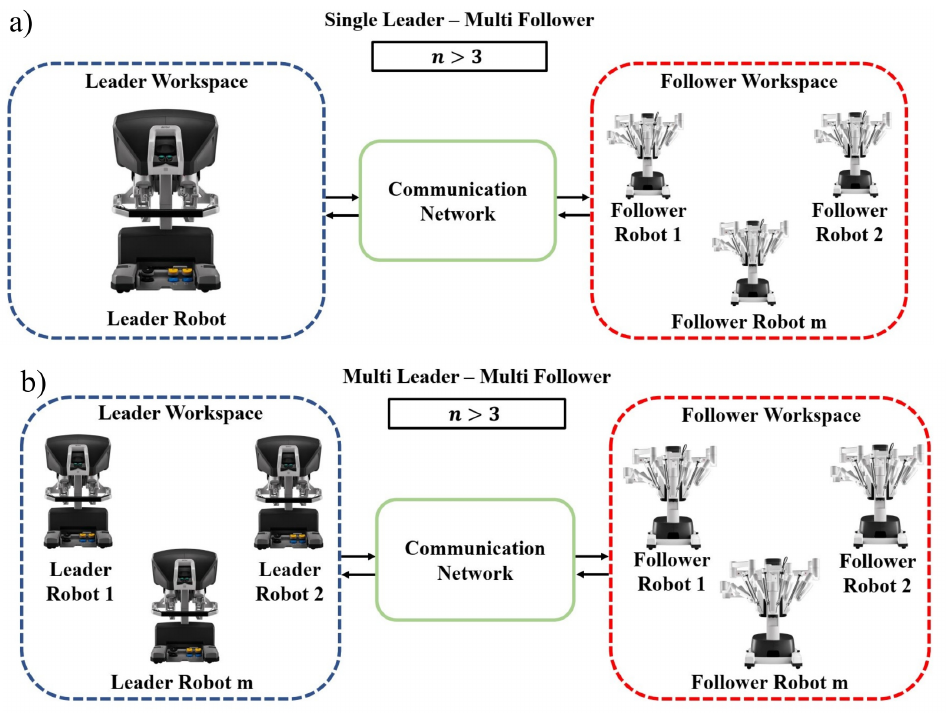
Figure 5. Multilateral topologies used in telerobotics, n is the number of network ports/terminals. ( a ) Single leader–multi follower ( b ) multi leader–multi follower (Images ©2020 Intuitive Surgical,